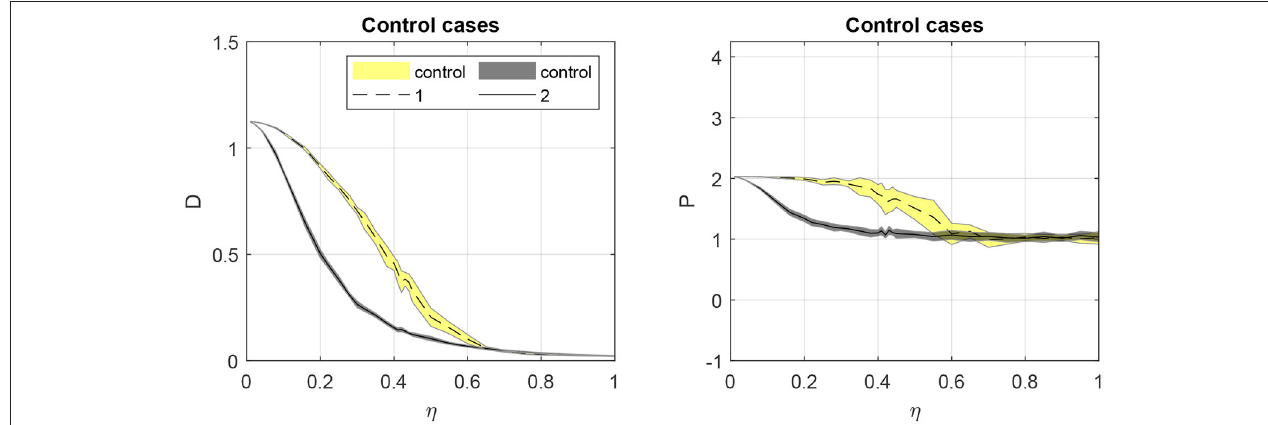
FIGURE 5 | Diffusion coefficient D (left) and the diffusion exponent P (right) as a function of the noise amplitude η for the two control cases. Control 1 is the native Vicsek model with no obstacles in the domain; control 2 is random walker dynamics with no interactions between the particles. Shaded regions indicate mean standard deviation over the 20 Monte Carlo